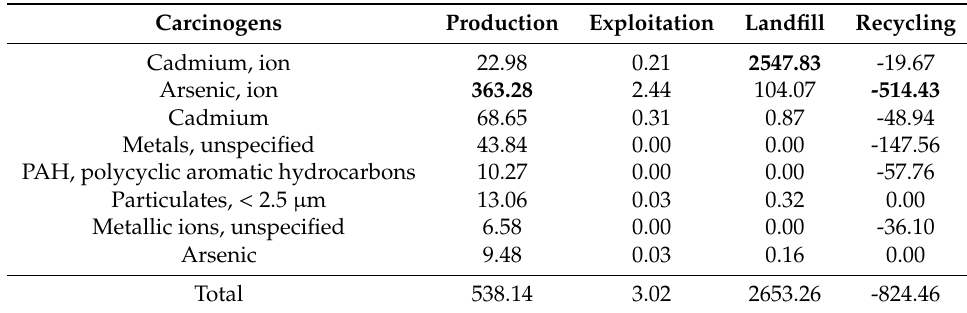
Table 4. Results of grouping and weighting environmental after-e ff ects for carcinogenic compounds present in the 1 megawatt photovoltaic power plant [unit: